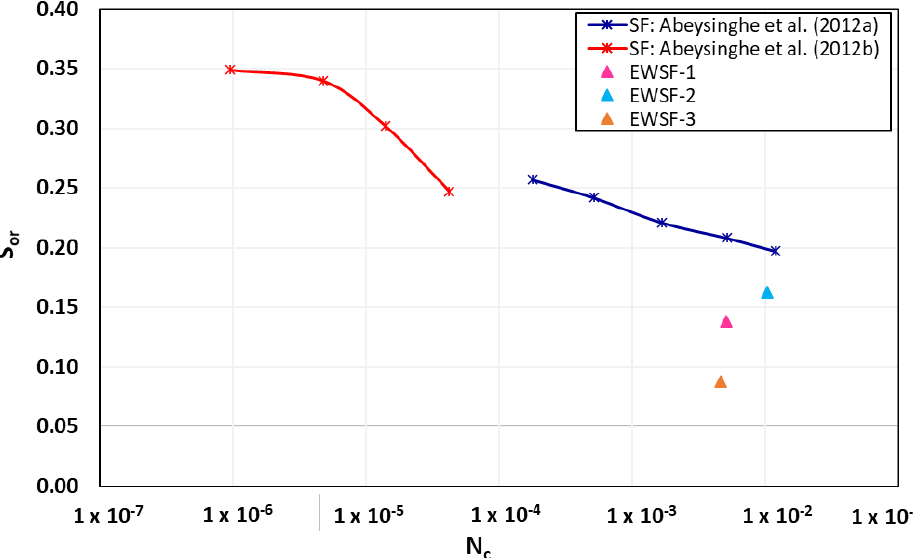
Figure 2. Comparison of capillary desaturation tendency of hybrid EWSF with conventional SF.